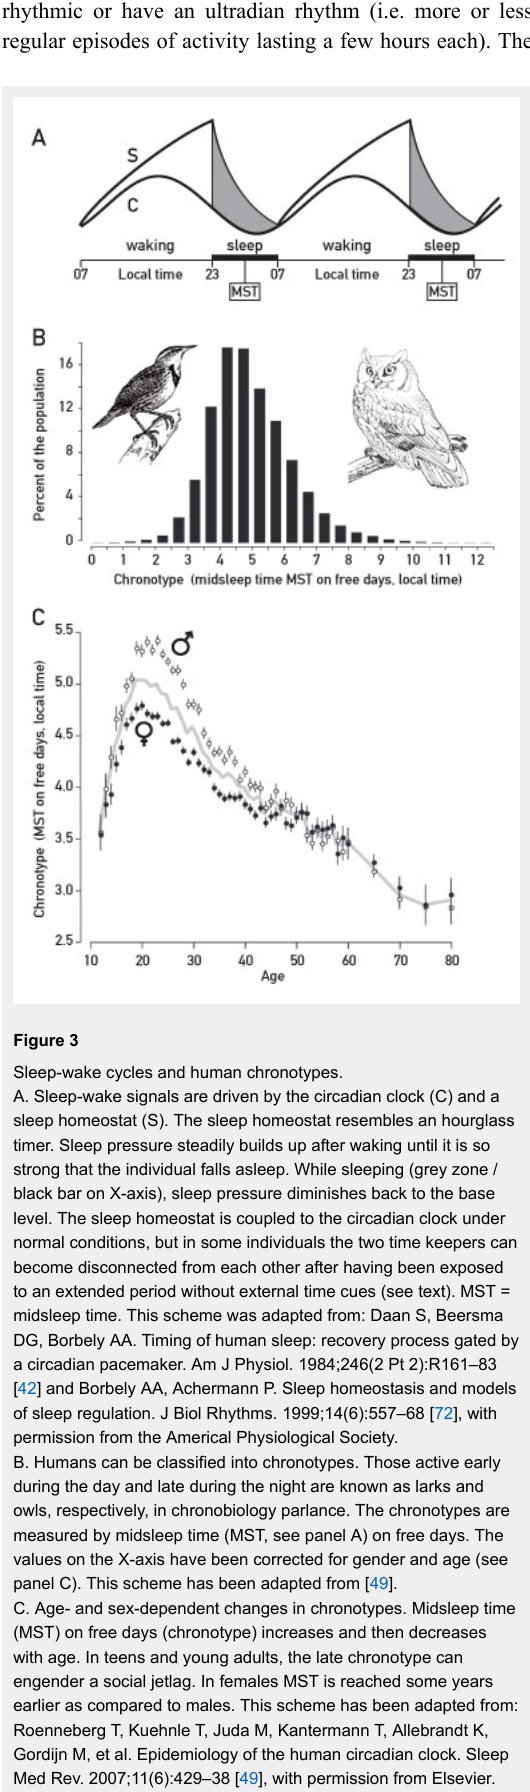
C. Age- and sex-dependent changes in chronotypes. Midsleep time (MST) on free days (chronotype) increases and then decreases with age. In teens and young adults, the late chronotype can engender a social jetlag. In females MST is reached some